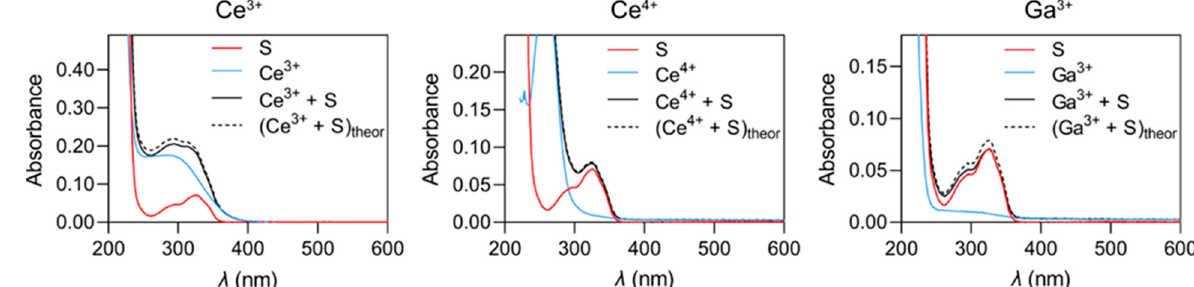
Figure 1. Absorption spectra of Ce 3+ , Ce 4+ , and Ga 3+ salts in the presence and absence of the synthetic substrate Z-Phe-Arg-AMC. Spectra were recorded in 50 mM sodium acetate buffer pH 5.5 in a quartz cuvette with an optical path of 1 cm. The concentrations of Ce 4+ and Ga 3+ ions in the experiments shown were 0.5 mM and the concentration of Ce 3+ ions was 0.05 mM. The concentration of the substrate was 5 µM.